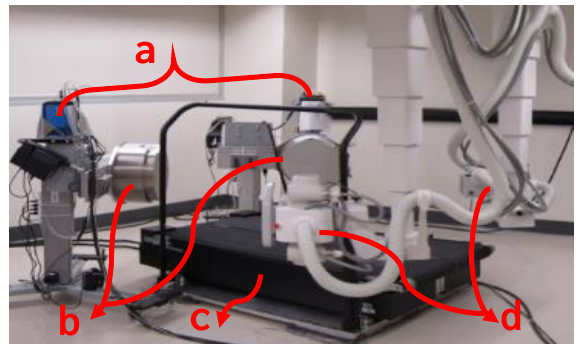
Figure 1. DF imaging system components, (a) high-speed cameras, (b) image intensifiers, (c) treadmill, and (d) X-ray sources